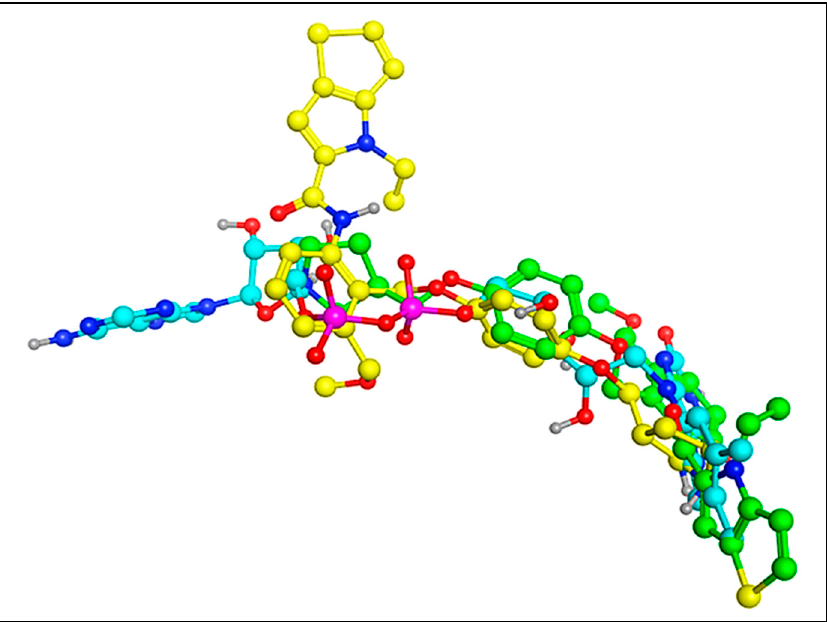
Figure 13. Comparison of the docked conformation of the compound 2 and 3 with the pdb- 2dw4 ligand. ( Green colored—Comp 2 ; yellow colored—Comp 3;s and cyan colored—pdb- 2dw4 ligand). The compound 2 ( P IC 50 = 8.174, fdonsp3C2B = 2, lipo_ringS 8Bc = − 0.2339) and 3 ( P IC 50 = 8.174, fdonsp3C2B = 2, lipo_ringS 8Bc = − 0.2339) differed from the compound 1 ( P IC 50 = 9.42, fdonsp3C2B = 6, lipo_ringS 8Bc = 0)